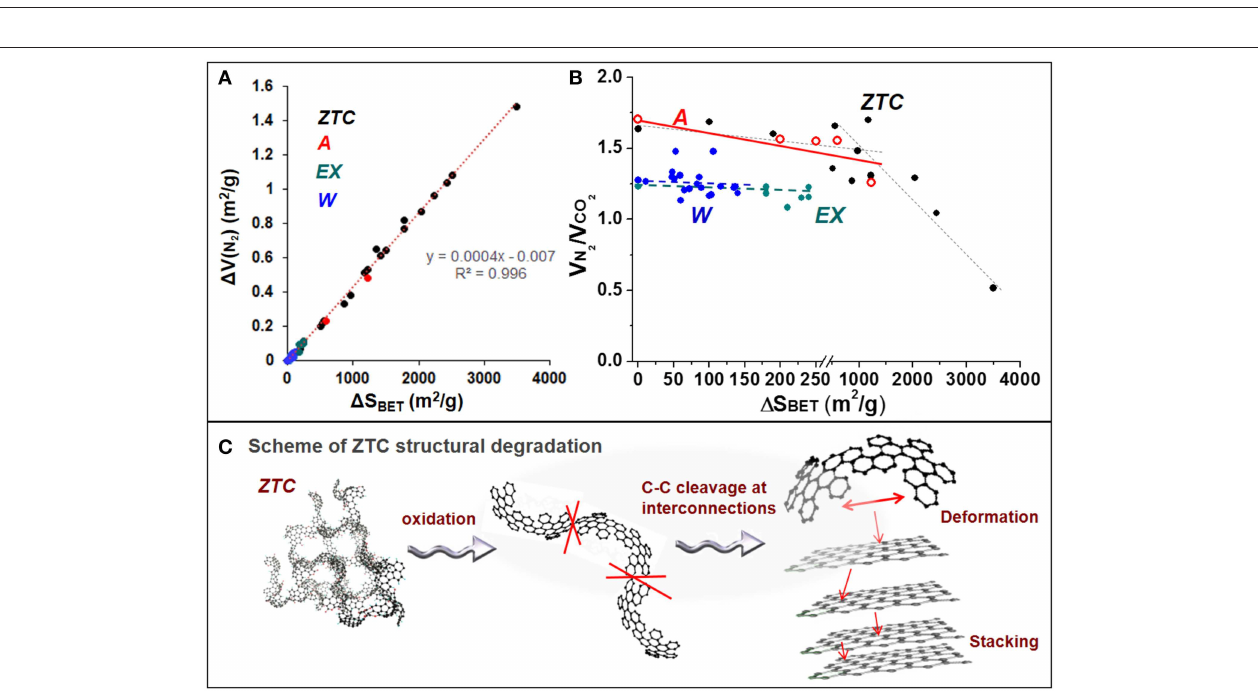
FIGURE 4 | (A) Relation between the change in specific surface area ( 1 S BET ) and that in the micropore volume ( 1 V(N 2 )); and (B) evolution of the VN 2 /VCO 2 ratio with the change in specific surface area, for the differently oxidized materials prepared for this study. (C) Proposed mechanism for the breakdown of ZTC structure (adapted from Nishihara et al., 2009) after different oxidative